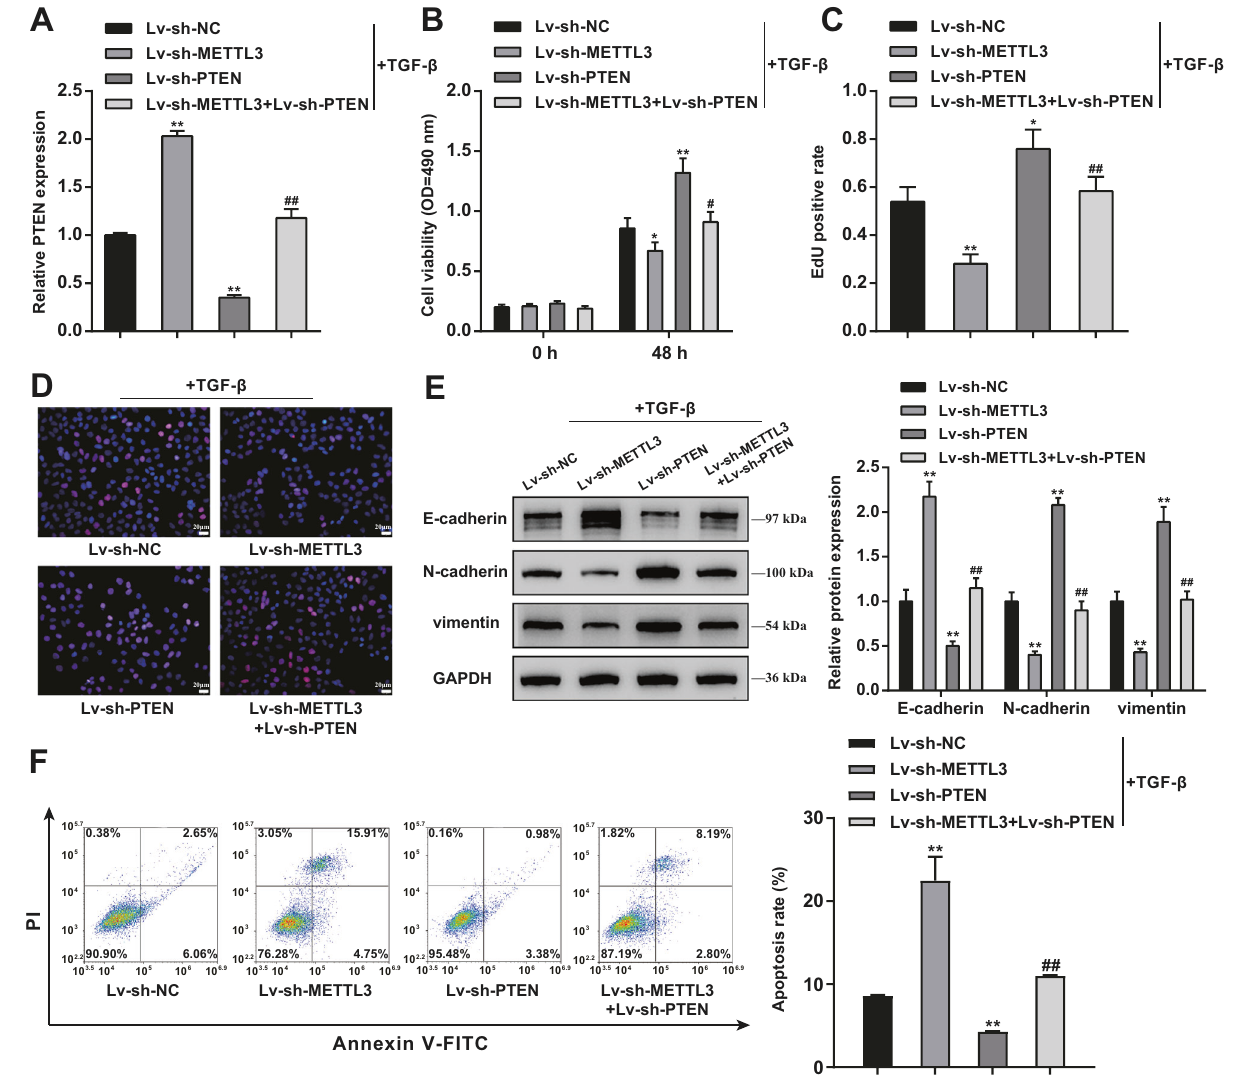
Fig. 7 METTL3 affects the cell phenotypes of TGF- β -stimulated. BPH-1 cells through PTEN BPH-1 cells were co-transduced with Lv-sh- METTL3 and Lv-sh-PTEN and examined for PTEN mRNA expression using qRT-PCR ( A ); cell viability using MTT assay ( B ); DNA synthesis using EdU assay ( C , D ); Scale bar = 20 μ m; the protein levels of E-cadherin, N-cadherin, and vimentin using Immunoblotting ( E ); cell apoptosis by Flow cytometry ( F ). ** P < 0.01, compared with the Lv-sh-NC group. ## P < 0.01, compared with the Lv-sh-METTL3 group. knockdown signi fi cantly inhibited p53, c-Myc, NF- κ B, Zeb1, Zeb2, Snail, and Twist1 levels; whereas PTEN knockdown notably promoted p53, c-Myc, NF- κ B, Zeb1, Zeb2, Snail, and Twist1 levels, and PTEN knockdown partially attenuated the effects of METTL3 on these transcription factors. METTL3 affects TGF- β -stimulated BPH-1 cell phenotype through PTEN In vitro, BPH-1 cells were co-transduced with Lv-sh-METTL3 and Lv-sh-PTEN and examined for PTEN mRNA expression. Similar to in vivo results, PTEN expression was upregulated after knocking down METTL3 but downregulated after Lv-sh-PTEN transduction (** P < 0.01), whereas Lv-sh-PTEN signi fi cantly reversed the effects of METTL3 knockdown upon PTEN expression (Fig. 7A). Regard- ing cell phenotypes, METTL3 knockdown suppressed, while PTEN knockdown enhanced cell viability and DNA synthesis (** P < 0.01); PTEN knockdown partially attenuated METTL3 knockdown effects on BPH-1 proliferation (Fig. 7B – D). As for EMT markers, METTL3 knockdown upregulated E-cadherin but